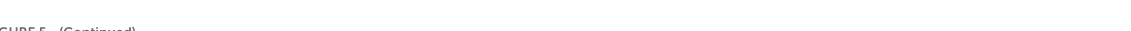
FIGURE5 (Continued) confirming differences in the activation patterns of these neuronal groups (separation with the same color denotes the same neurons with different activation patterns). (C) Directed graph of neuronal ensemble temporal transitions; each node represents an ensemble. Arrows Edges are functional connections between them: color indicates the origin and arrowheads the destiny; the thickness of the edges represents the number of times a transition was carried out in the observed data. Some transitions can be identified in the raster plot even if the sorting procedure (see the Section 3.4) did not show them together. (D) Projections on the combinations of UMAP planes of the column vectors shown in section B. (E–H) Ensemble coactivation patterns in the decorticated striatum. Background neuronal activity is considerably lower than in control conditions and compared with the pathological states below (cf. histograms of % cell activity at right). Although numerous groups can be separated in section F, scarce temporal sequences (arrows in G) form a ring structure with many unidirectional connections. (I–L) Coactivation patterns of neuronal ensembles identified in striatal tissue depleted of dopamine (6-OHDA Parkinsonian model). There are fewer connections (K) between ensembles that are activated at regular times (I) . A more frequent transition appears (K; blue to orange). (M–O) Patterns of significant coactivation of neuronal ensembles identified in the striatum under the model of L-DOPA induced dyskinesia (LID): ensembles are projected in the low-dimensional space (N) , as well as transitions (M,P) , with several recurrences and high background activity (% activity histogram at right; note scale